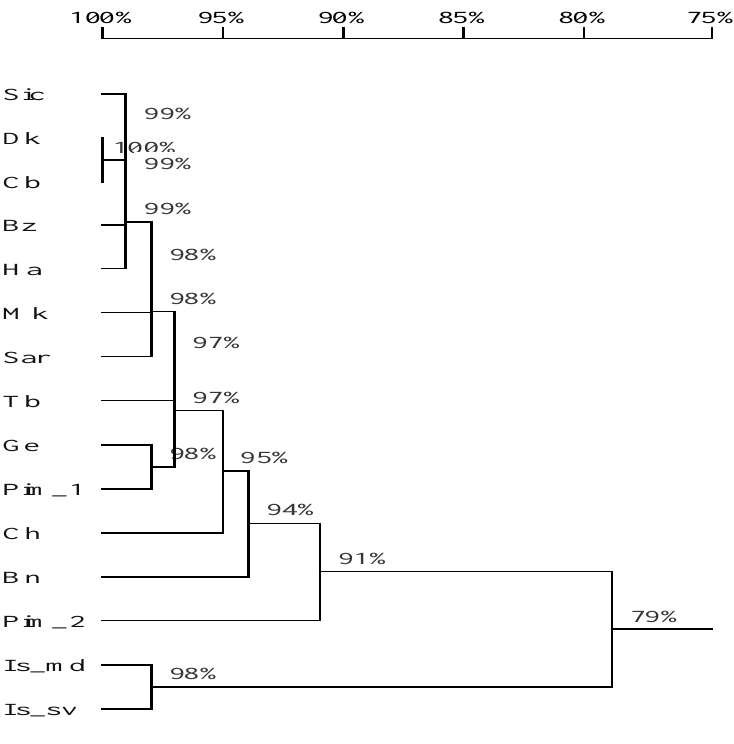
Fig. 4. Phylogenetic tree showing relationships among coat protein genes of Tunisian isolates and other known TYLCV strains. Numbers above the branches indicate percentage of homology. Horizontal branches are proportion- al to sequence